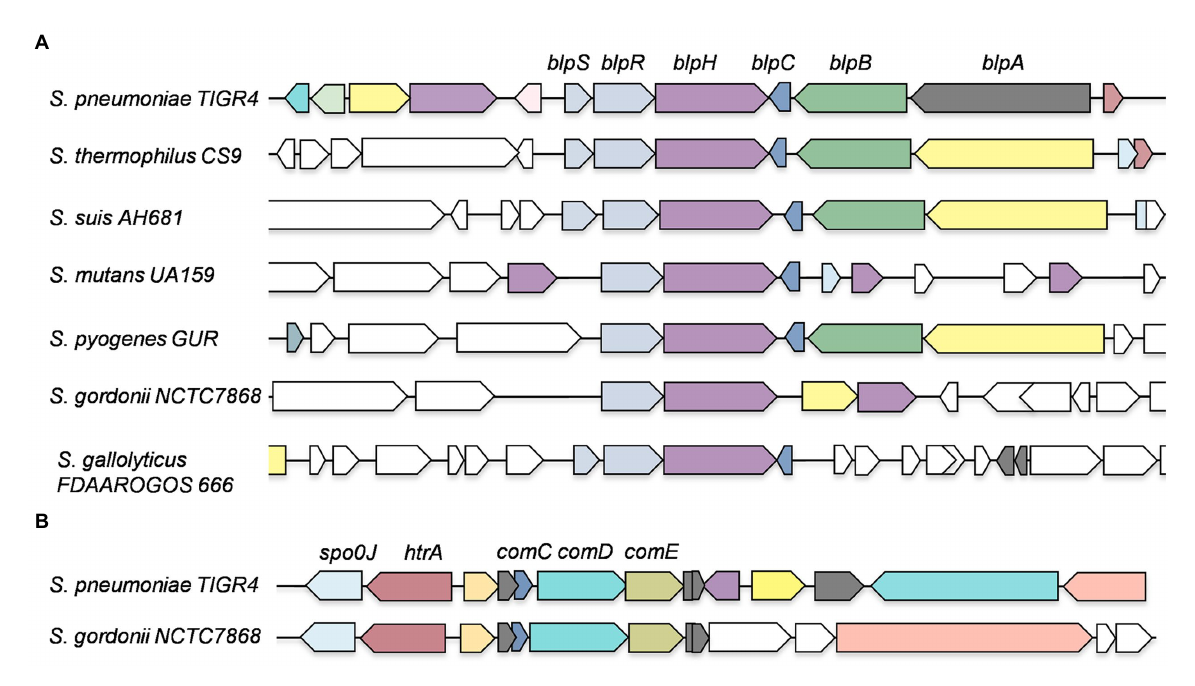
FIGURE 3 Genomic organization of BlpRH and ComDE pathways in various streptococcal genomes. (A) A streptococcal species from each group was selected and SyntTax was performed by using BlpH SPN sequence as an input file. Note that some streptococcal strains encode an additional gene, blpS , which has been shown to be necessary for expression. (B) A SyntTax profile of ComDE pathways was performed using ComD SPN sequence as an input